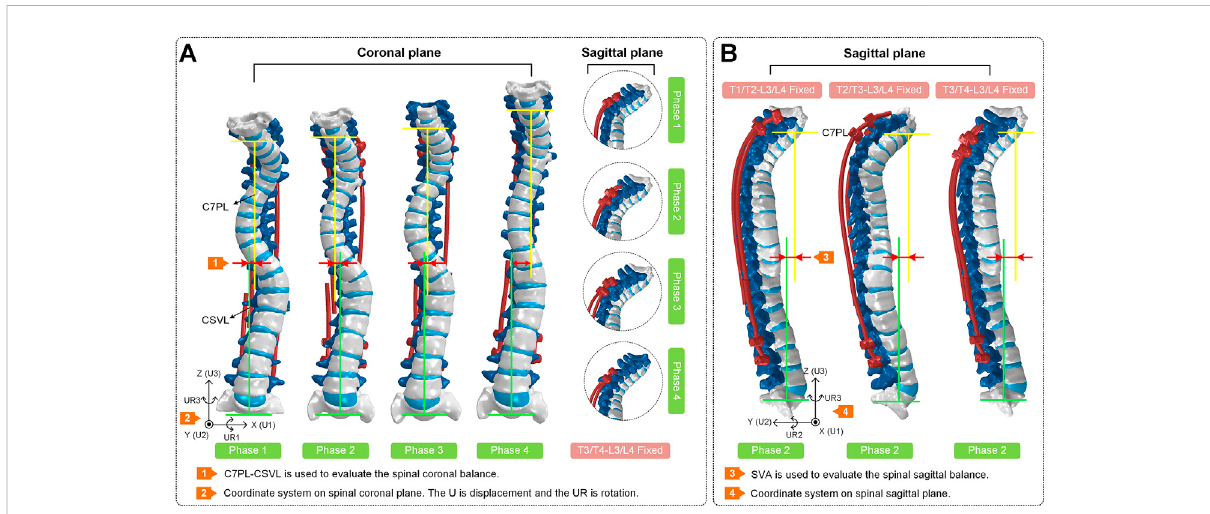
FIGURE 3 (A) Coronal view and sagittal view of the spines at four phases. The T3/T4-L3/L4 segments of each spine are fi xed. The coronal balance parameters (C7PL-CSVL) of four models are shown to evaluate the surgical effects. (B) Sagittal view of spines in surgical phase 2. The T1/T2-L3/L4, T2/T3-L3/L4 and T3/T4-L3/L4 segments of each spine are fi xed separately. The sagittal balance parameters (SVA) of three models are shown to evaluate the surgical effects.